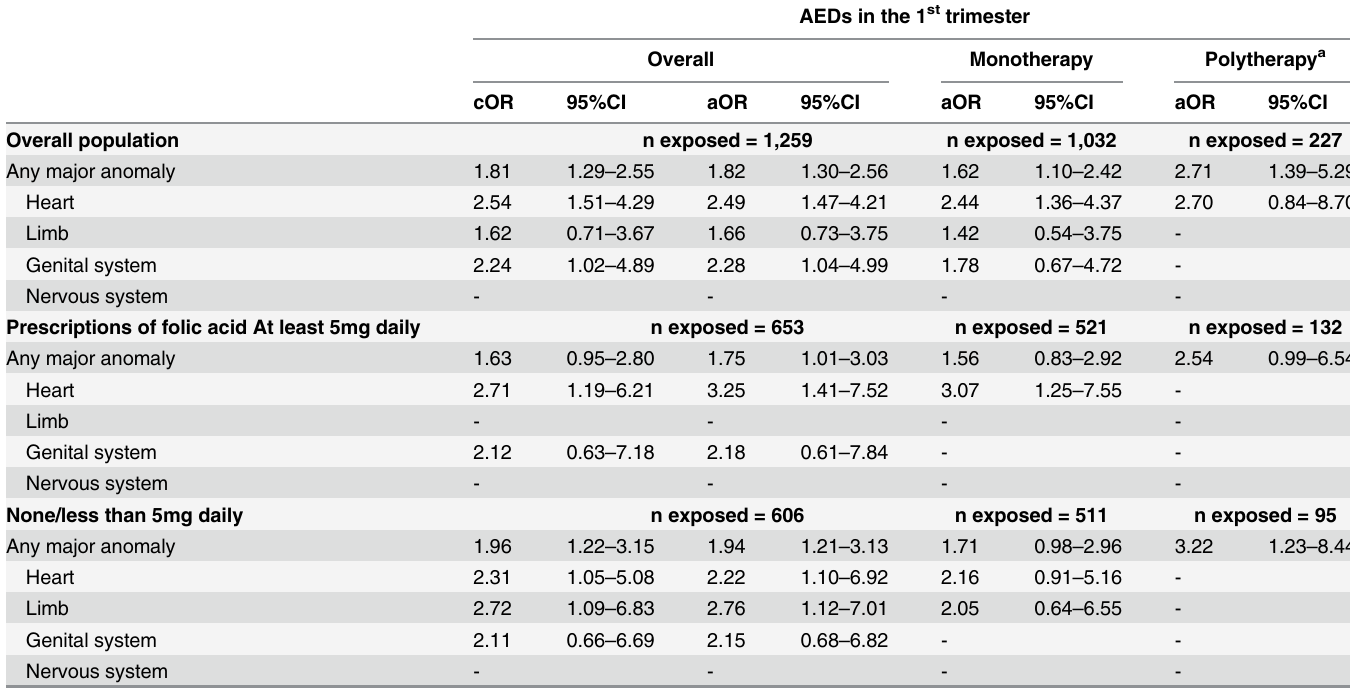
Table 3. Odds ratios for the association of major congenital anomalies with antiepileptic drugs in the 1 st trimester of pregnancy and risk stratifica- tion according to whether high dose (5mg daily) folic acid was prescribed *